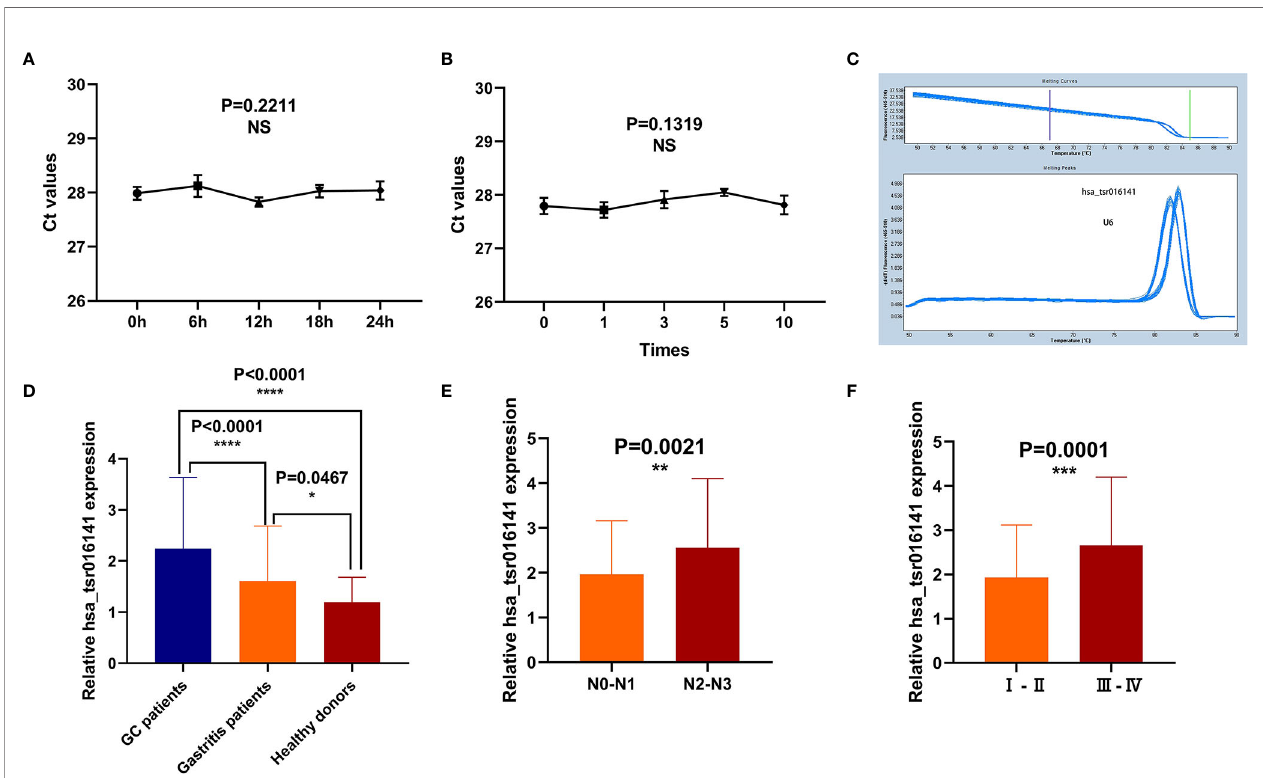
FIGURE 4 | Methodological evaluation and biomarker potential of hsa_tsr016141. (A, B) The detection method of hsa_tsr016141 would not be easily affected and had good stability and repeatability. (C) The melting curve of hsa_tsr016141. (D) The expression level of hsa_tsr016141 in GC patients (n=130), gastritis patients (n=50), and healthy donors (n=110). (E) The expression levels of hsa_tsr016141 in serum samples of GC at different stages of lymph node metastasis. (F) The expression levels of hsa_tsr016141 in serum samples of GC at different stages of tumor grade. *P < 0.05, **P < 0.01, ***P < 0.001, ****P < 0.0001, NS P >